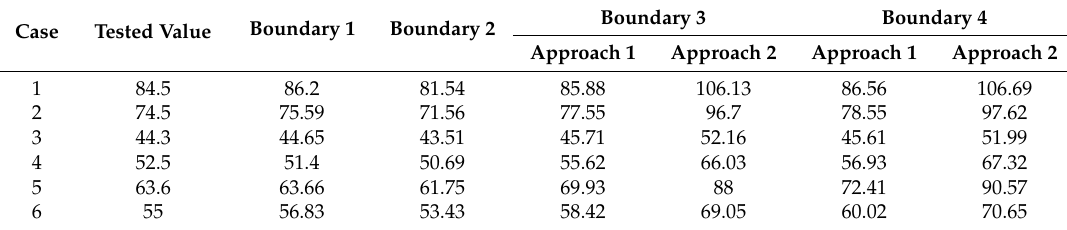
Table 4. Steady conductor temperatures obtained by FEM simulations ( ◦